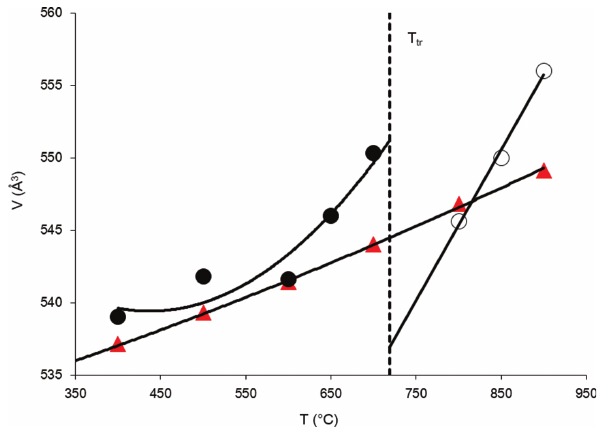
Figure 4: Thermal dependencies of unit cell volume for sol-gel hydroxyapatite before (black circles), after polymorphic transition (white circles), and for solid-state hydroxyapatite (red triangles).